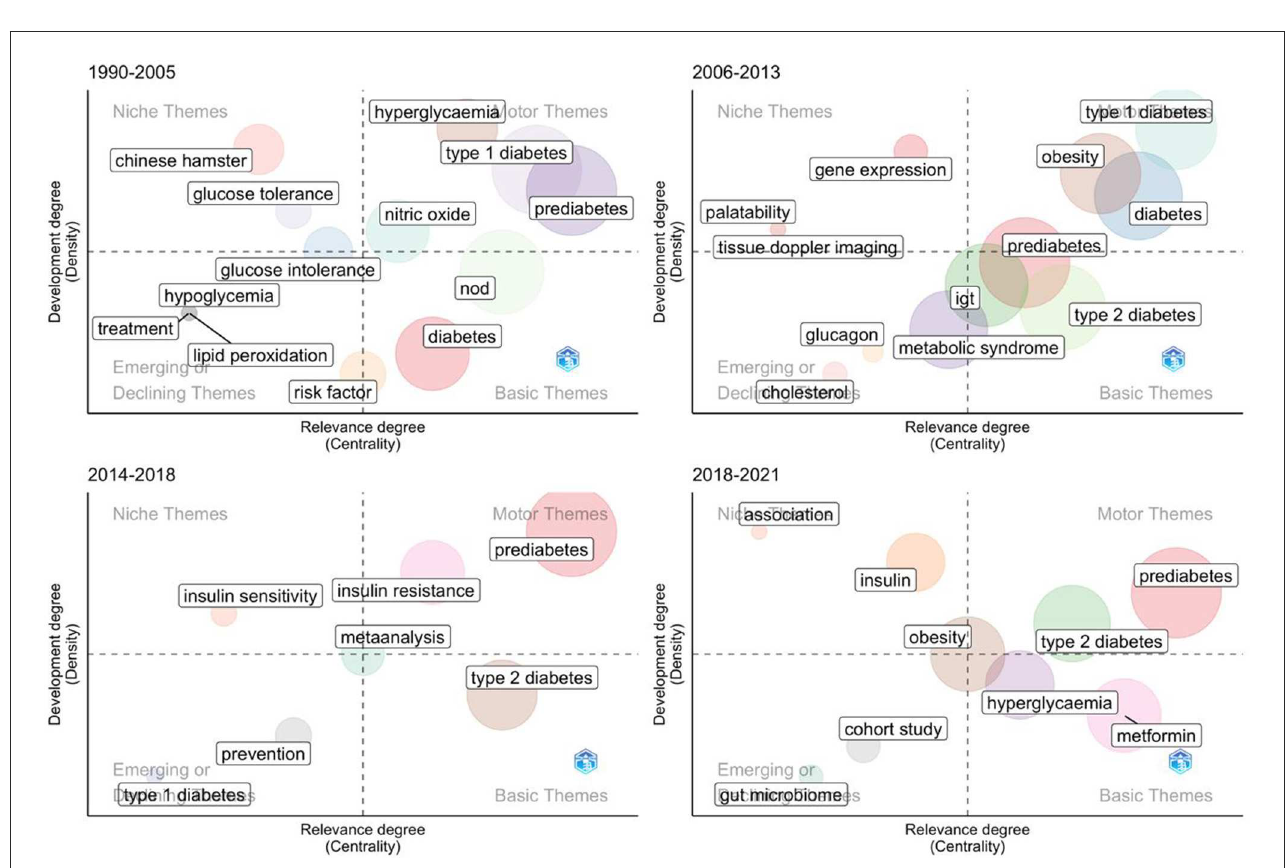
FIGURE7 Strategic diagram for four